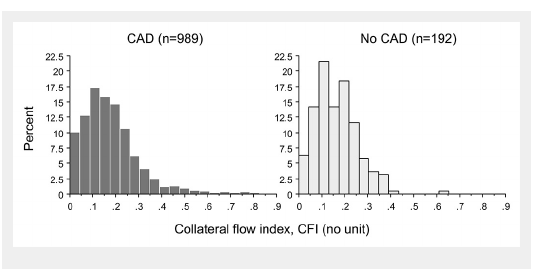
Relation between the fractional flow reserve (FFR) difference (post- ischaemic minus adenosine-induced FFR, x-axis) and collateral flow index as obtained in the same vessel (y-axis).